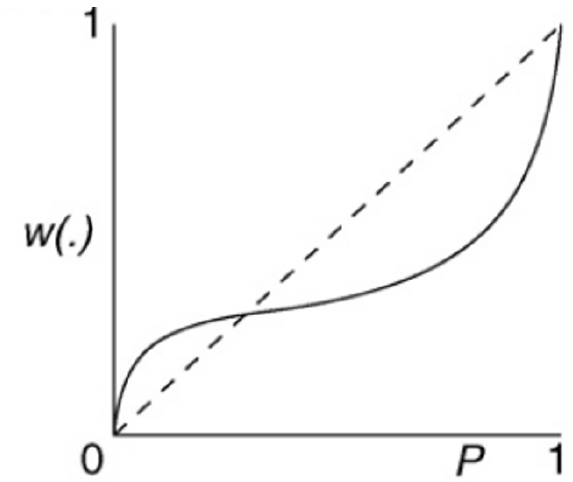
Figure 1. Nonlinear function of probability (P) in the behavioral decision